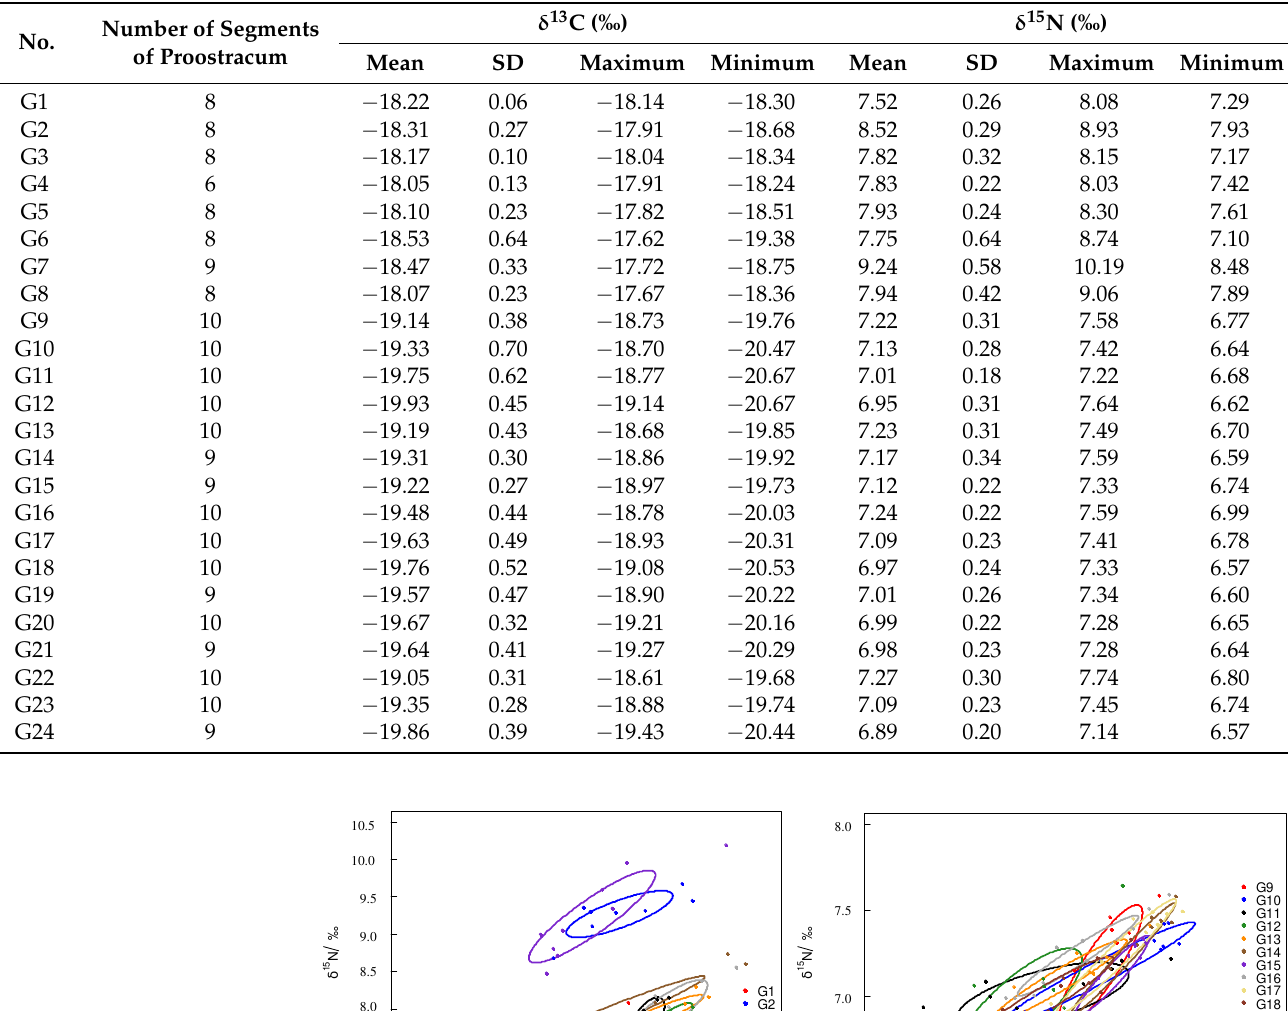
Table 2. Stable isotope values of the gladius of T. pacificus .